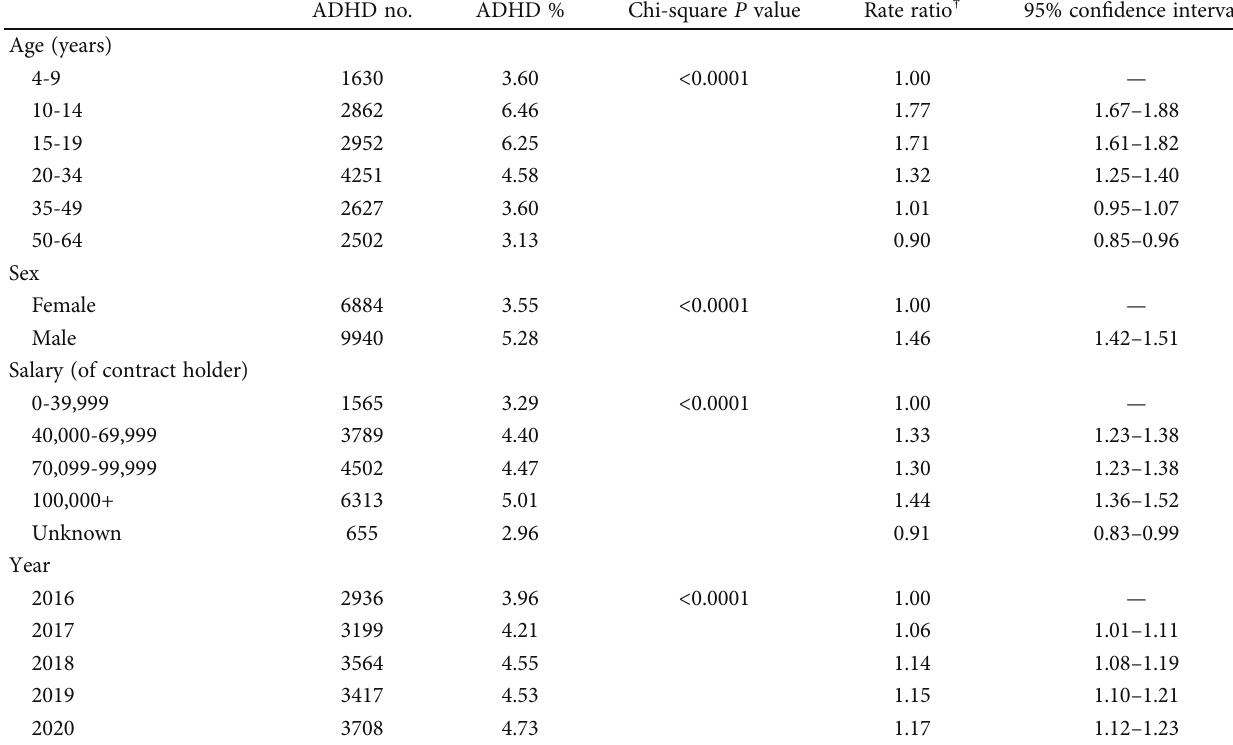
Table 1: Attention-de fi cit hyperactive disorder (ADHD) in the Deseret Mutual Bene fi t Administration (DMBA) population according to selected variables, 2016-2020.